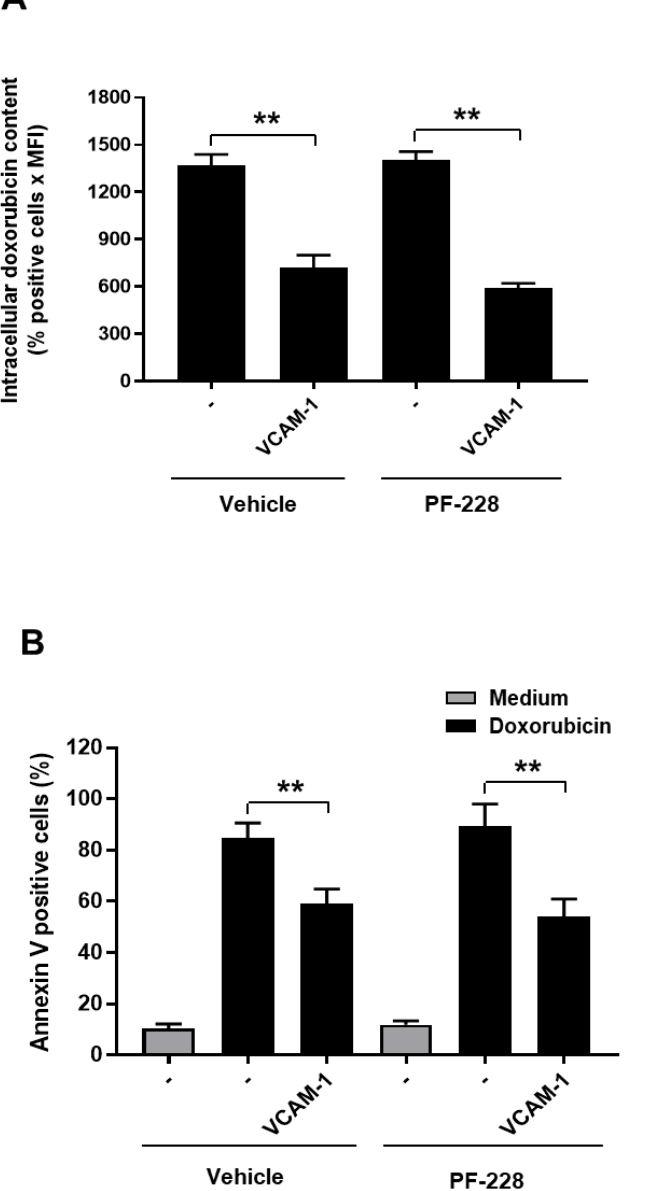
Figure 6. T-ALL chemoresistance mediated by VCAM-1 is FAK-independent. ( A ) The FAK inhibitor did not affect VCAM-1-induced drug efflux. Jurkat cells were treated with vehicle ( − ) and the FAK inhibitor PF-228 (0.5 µ M) for 1 h and then seeded on VCAM-1 for 4 h. Adherent cells were treated for 2 h with 100 ng/mL of doxorubicin and intracellular doxorubicin content was determined by FACS analysis. ( B ) The FAK inhibitor did not affect VCAM-1-induced T-ALL chemoresistance. The cells were treated as in ( A ) and apoptosis was determined after 48 h of treatment with 50 ng/mL of doxorubicin by annexin V staining and FACS analysis. Results represent mean values ± S.D. of three independent experiments. ** p < 0.01 determined by the Student’s t